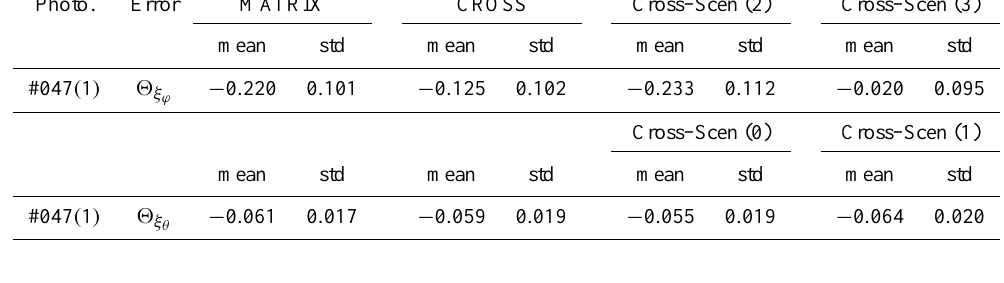
Torres et al.: Measurements on pointing error and field of view